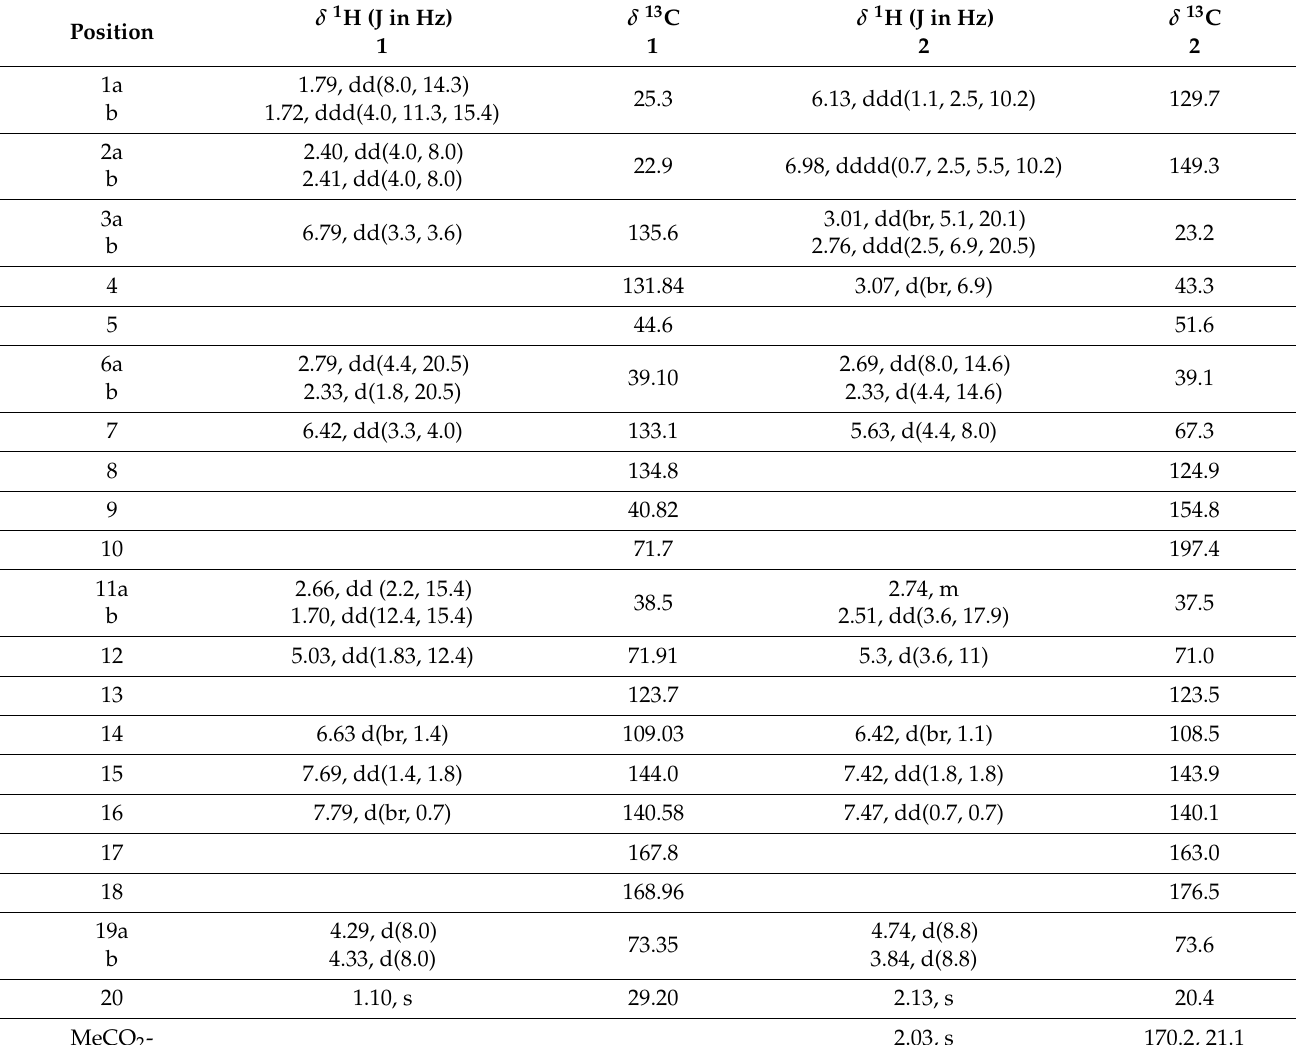
Table 1. NMR spectroscopic data for compounds 1 and 2 (600 MHz, CDCl 3 , δ